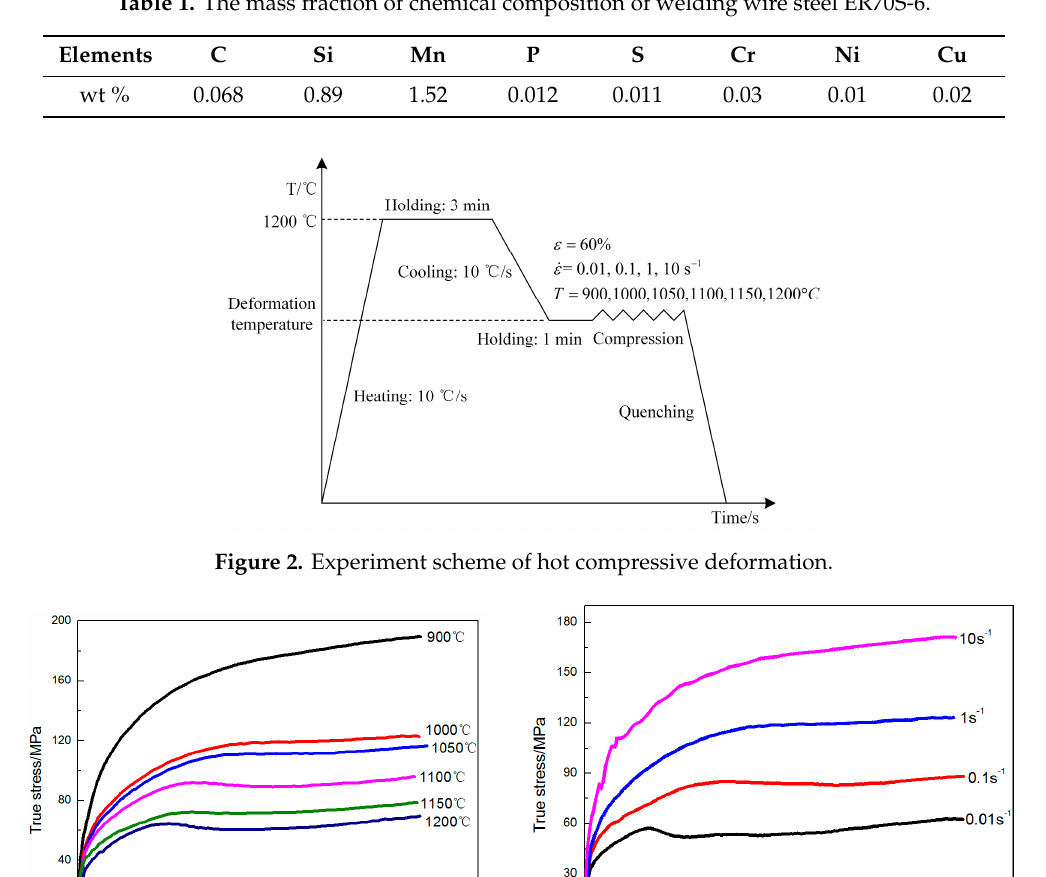
Figure 3. The typical true stress–strain curves under different deformation conditions: ( a ) and ( b ) T = 1000 °C . Table 2. Values of material constants of the constitutive equation.